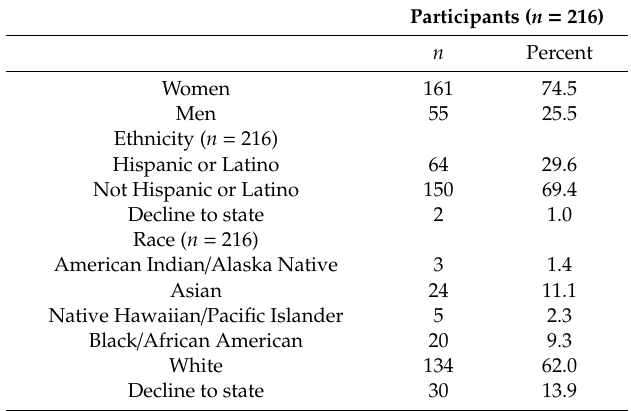
Table 1. Sex, ethnicity, and race characteristics of the study